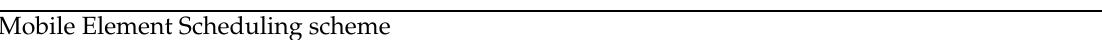
Algorithm 2 Mobile Element Scheduling